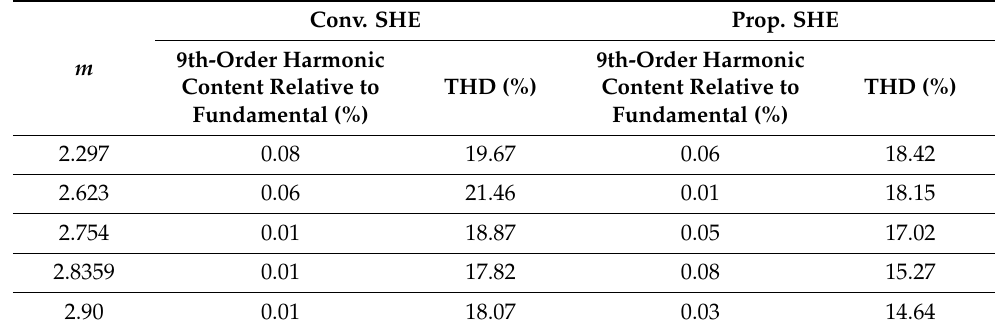
Table 3. Simulation results for 9th order harmonic